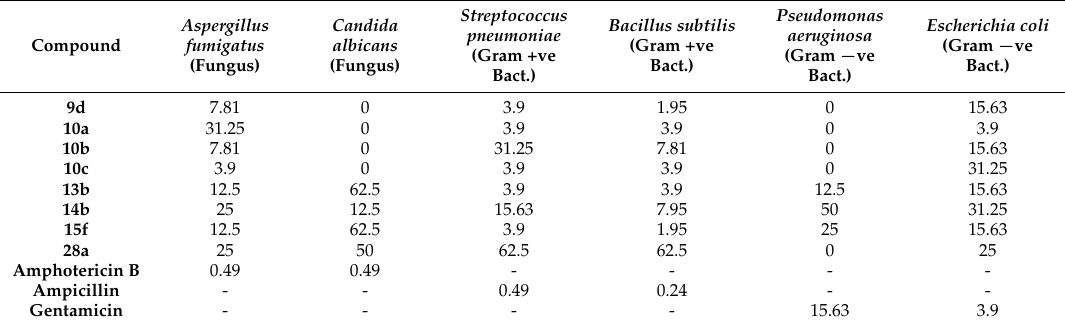
Table 2. Antimicrobial activity as MICS, (mg/mL) of tested samples against tested microorganisms.